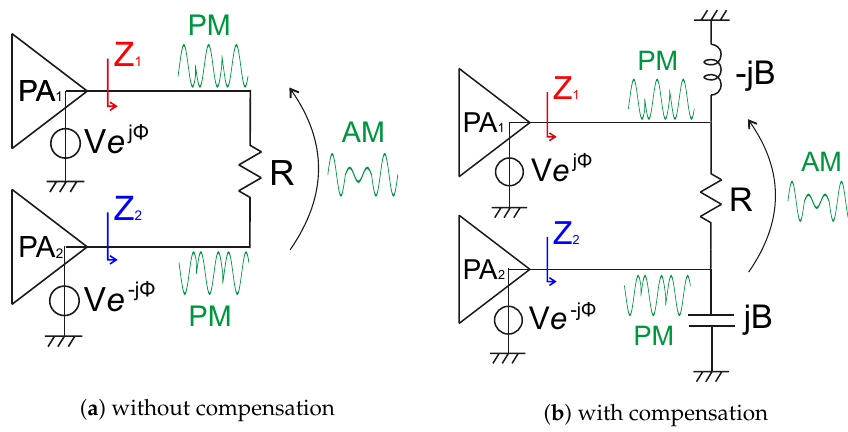
Figure 11. Simplified output section of an ideal Chireix outphasing amplifier.